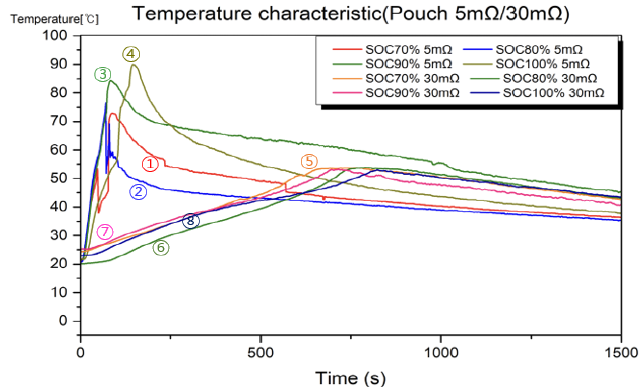
Figure 8. Temperature status of pouch cells during test with SOC and short-circuit resistance.